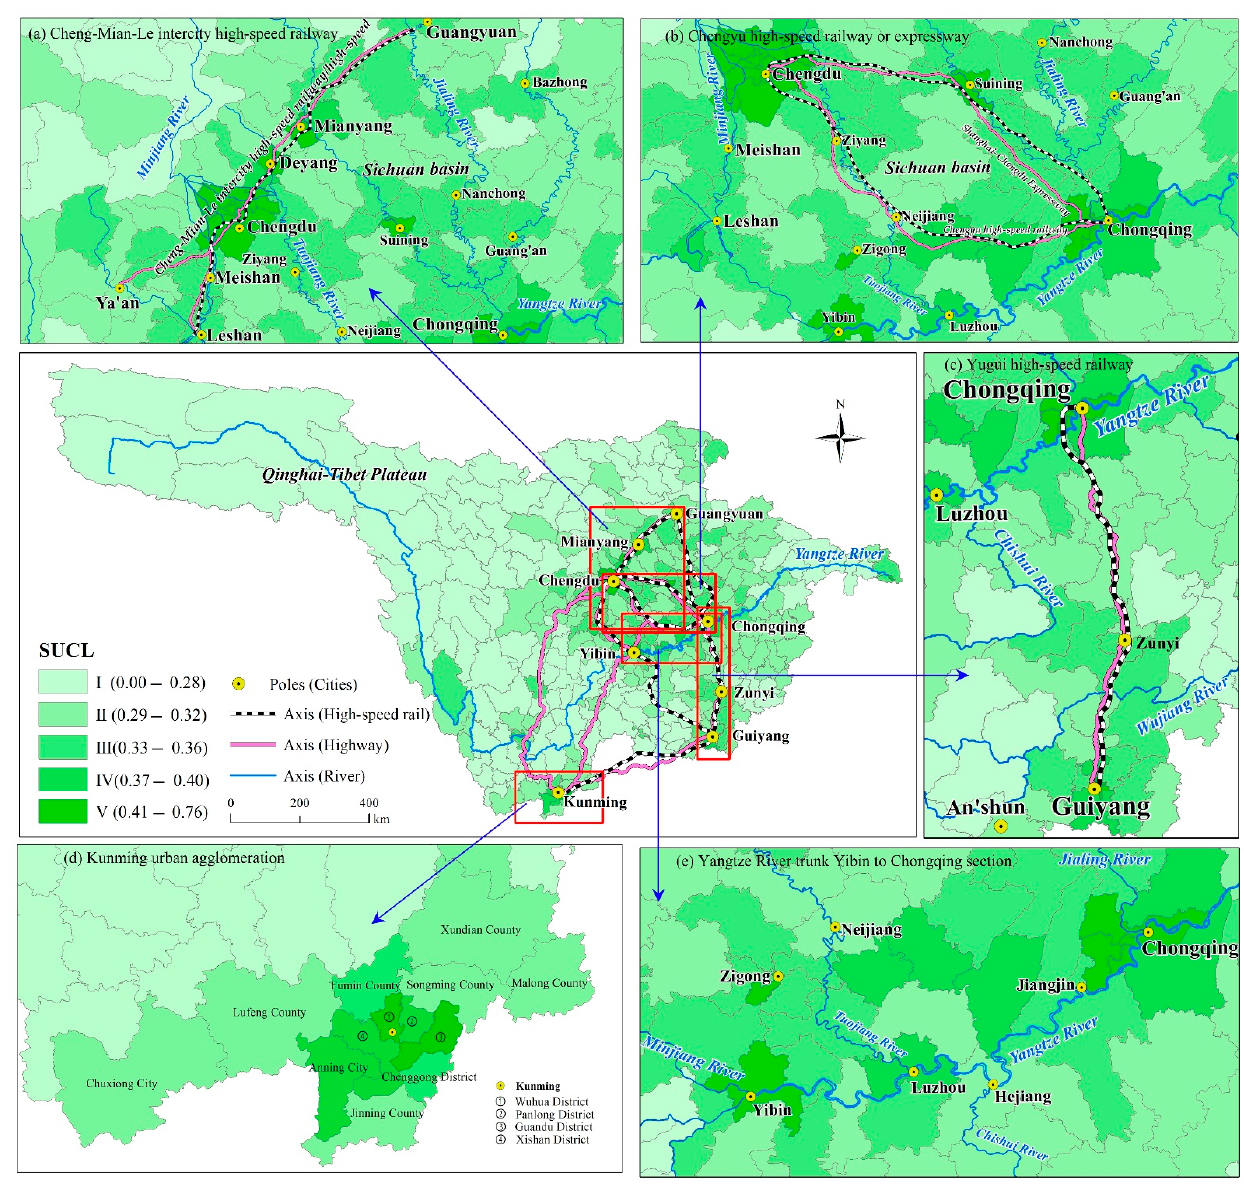
Figure 6. Pole–axis effect of the suitability of urban construction land (SUCL) spatial